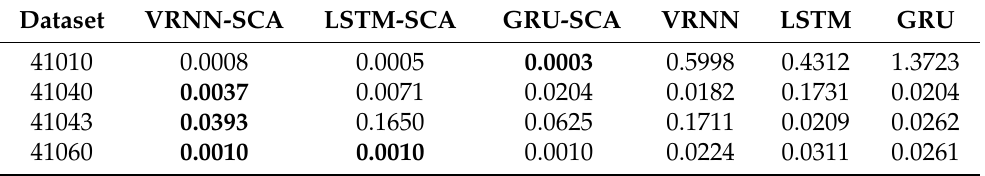
Table 11. Comparison in terms of average mean squared error (MSE) on all